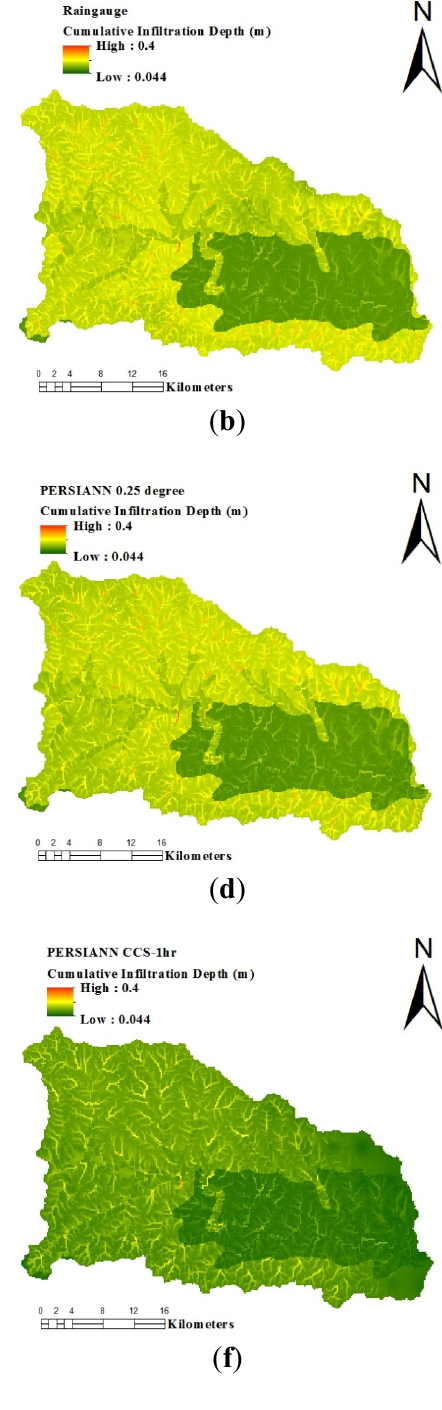
Figure 14. Spatial distribution of cumulative infiltration depths (m) driven by different precipitation products for the August 2007 event: ( a ) radar; ( b ) raingauges; ( c )